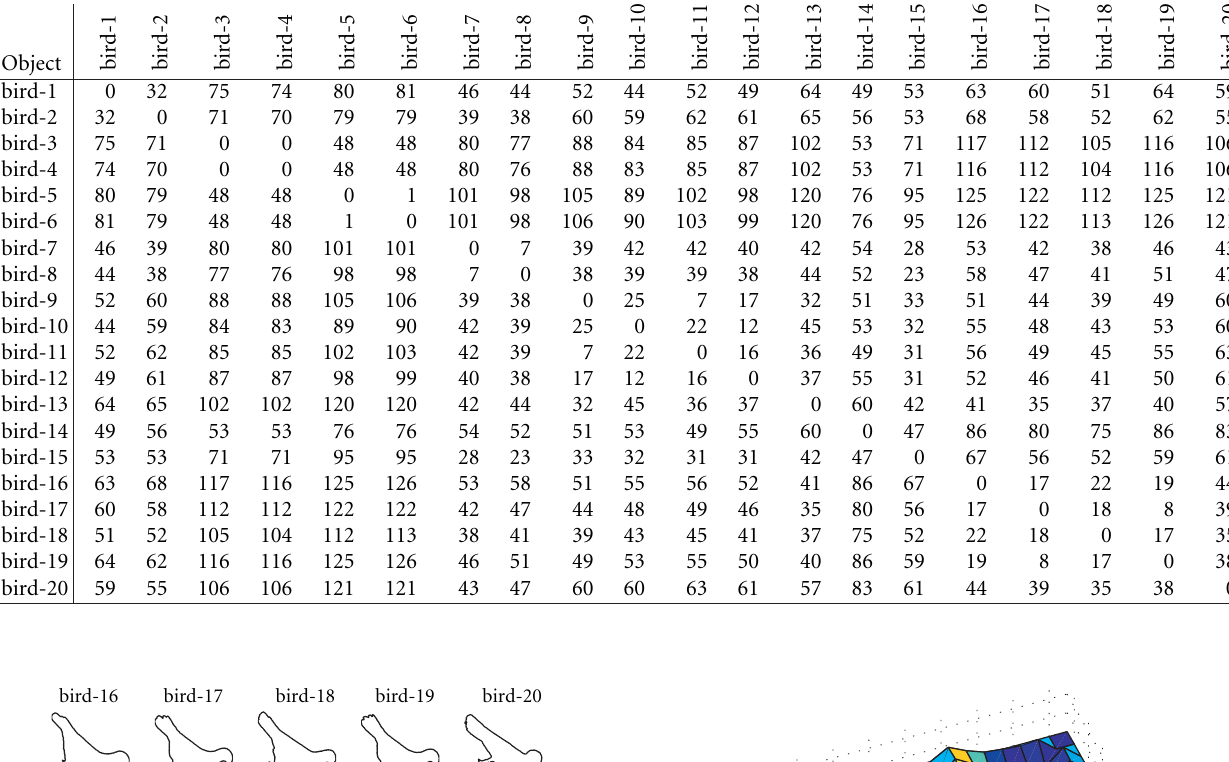
Table 1: Similarity scores for the contours in Figure 3. These scores are multiplied by 10 3 .